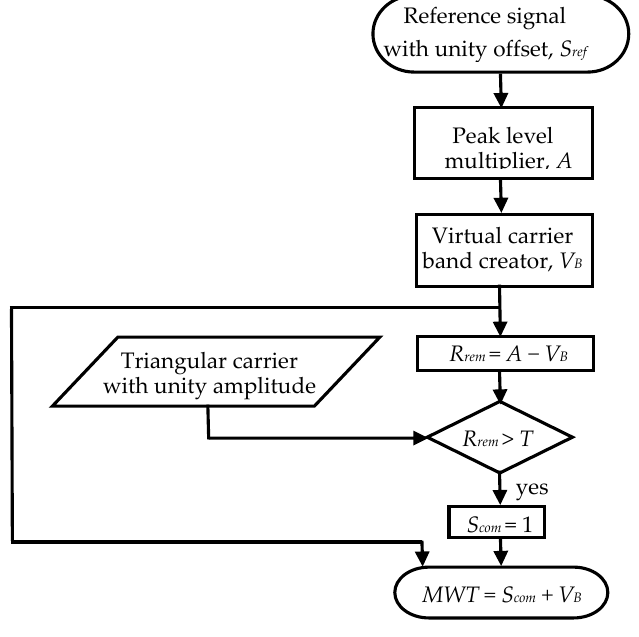
Figure 4. Flowchart for MWT waveform generation. Step-by-step derivation of the gating signals to the power switches is given in the flowchart of Figure 5.